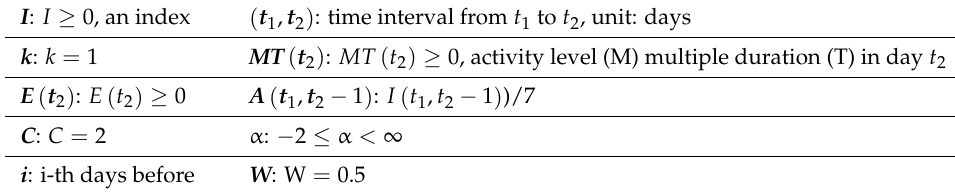
Table 2. Parameters of AAEI.